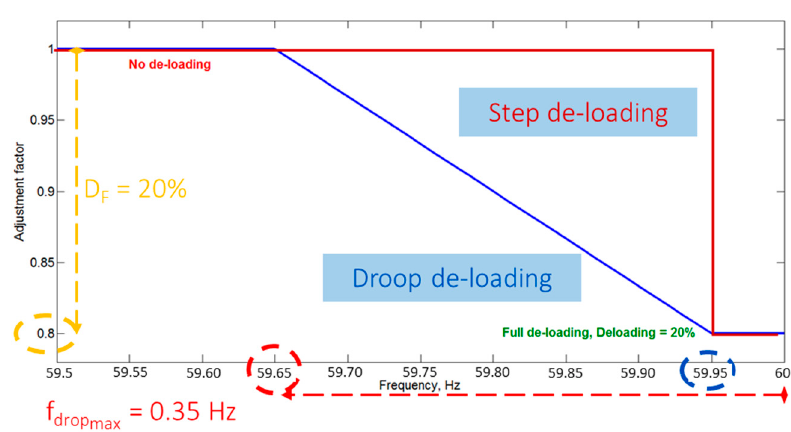
Figure 4. A F setting according to frequency variability and method of deloading.